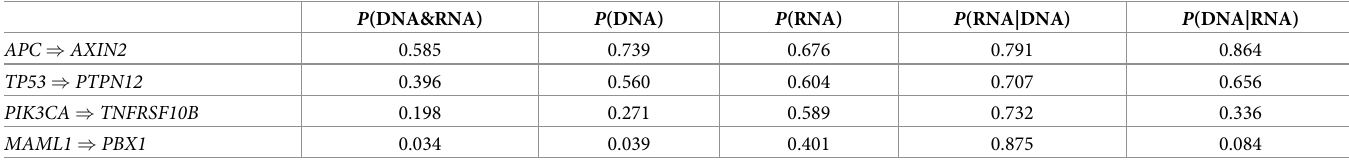
Table 2. Colon core STPs. There are four “core” STPs which appear in every minimal covering of the colon samples. P (DNA&RNA) is the fraction of samples for which the source gene g is DNA-aberrant and target gene g 0 is RNA-aberrant; P (DNA) is the fraction of samples satisfying the source gene g is DNA-aberrant; P (RNA) is the frac- tion of samples with g 0 RNA-aberrant; P (RNA|DNA) is the fraction of DNA-aberrant samples for which g 0 is RNA-aberrant.